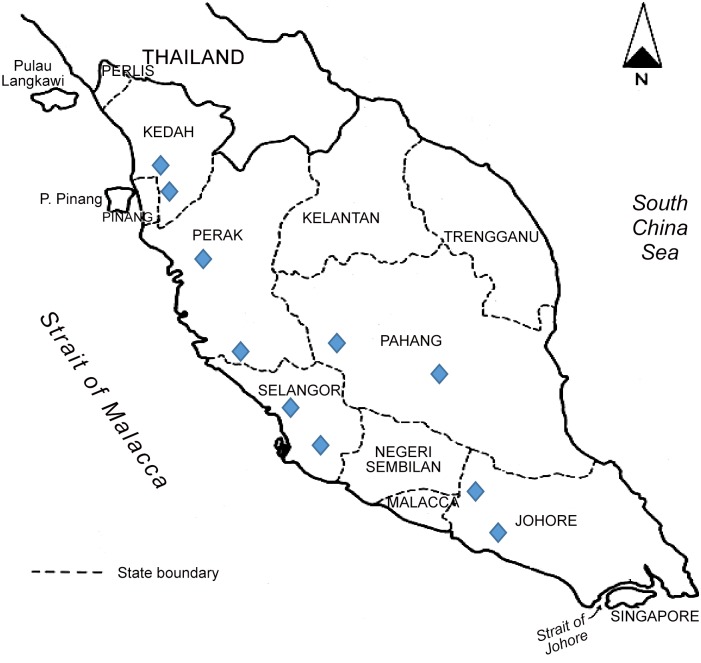
Geographical map of Peninsular Malaysia and study areas.—Indicates sample collection sites including both rural and urban areas. The rural and urban schools were identified based on the classification provided in the website of Ministry of Education, Malaysia.